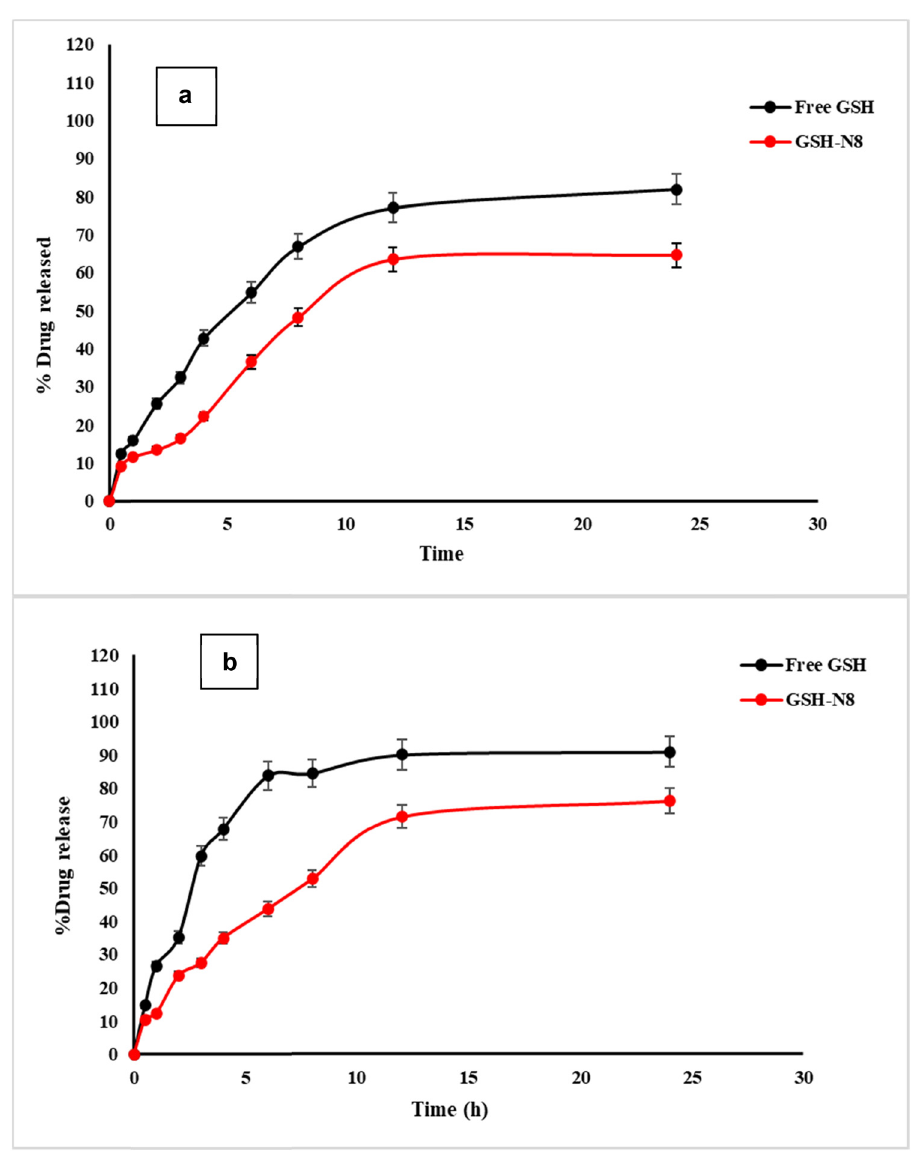
Figure 2: Release pro fi les of GSH ( free and selected niosomes ( formulation, GTN - 8 )) at pH 1.2 ( a ) and pH 6.8 ( b ) ( n = 3, mean ± SD ) .